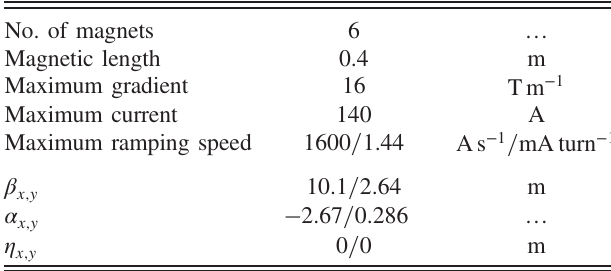
TABLE II. QF quadrupole family parameters.